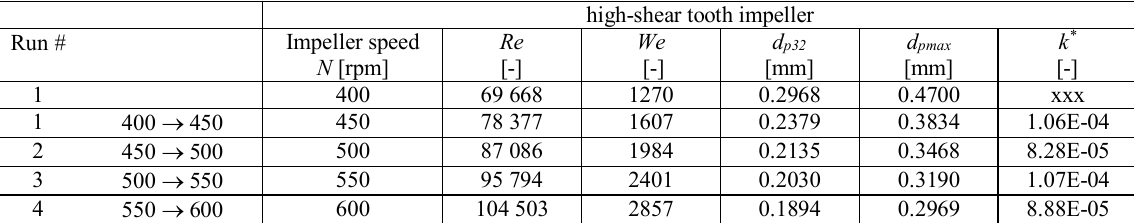
Table 9. Kinetic model parameters – high-shear tooth